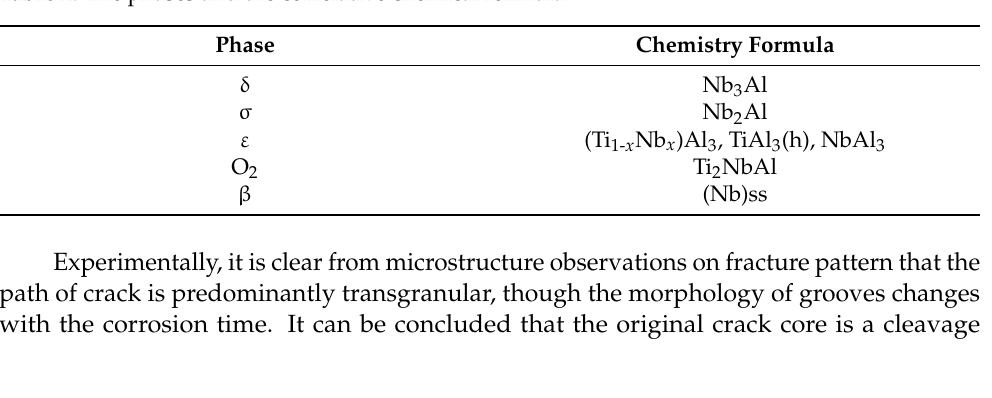
Figure 2. SEM images of interfacial crack along with interface evolution for different corrosion time at 1600 °C: ( a ) 0.2 h, ( b ) 0.5 h, ( c ) 1 h, ( d ) 1.5 h, ( e ) 2 h, ( f ) 2.5. Table 2. The phases and the correlative chemical